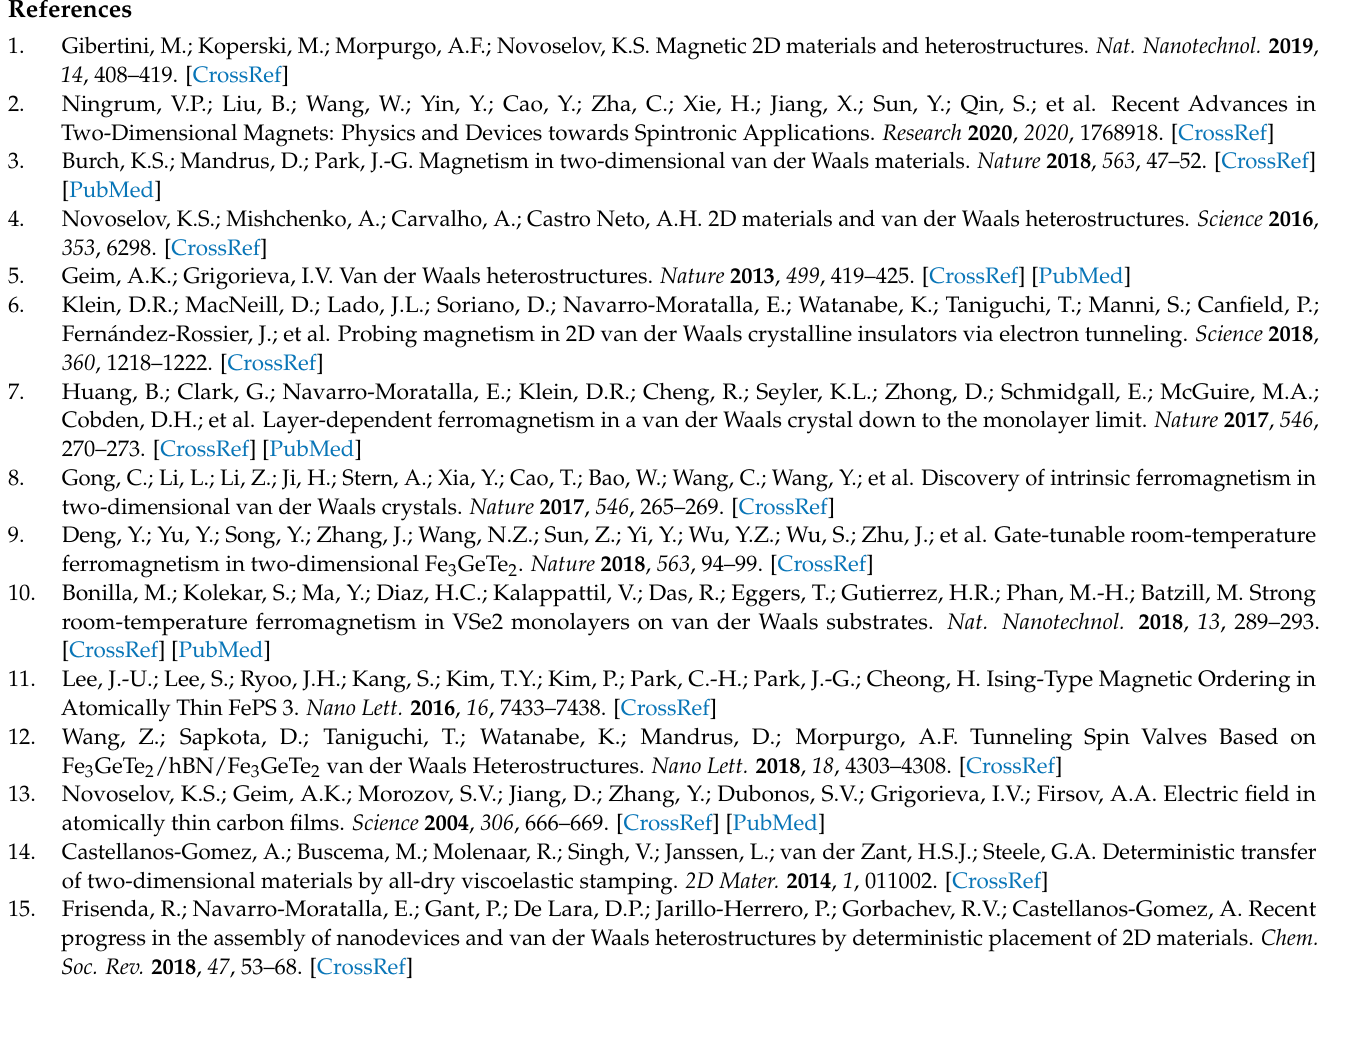
Supplementary Materials: Figures S1–S4: Additional Scanning Electron Microscopy (SEM)